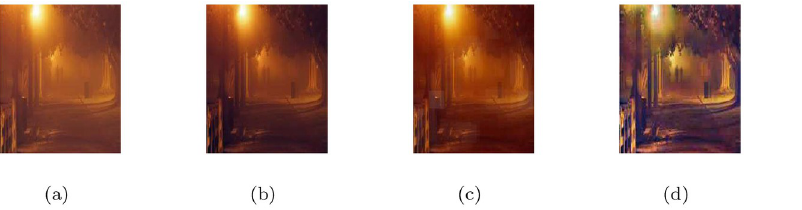
Fig 15. De-hazing performance of the M3 de-hazing model in comparison with the existing models and clear images. From L to R, columns represent the given images, Cho et al. [9] results, He et al. [4] results, M3-model results and clear images,